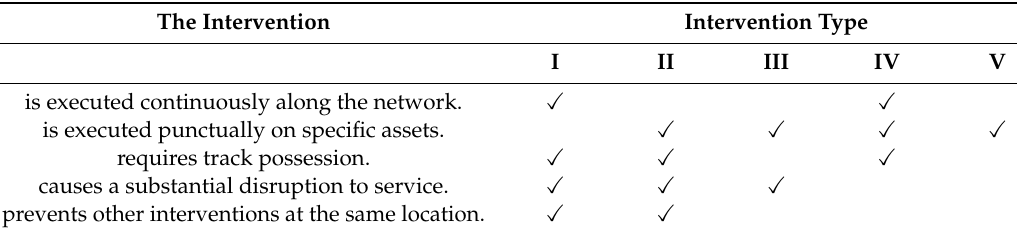
Table 2. Intervention